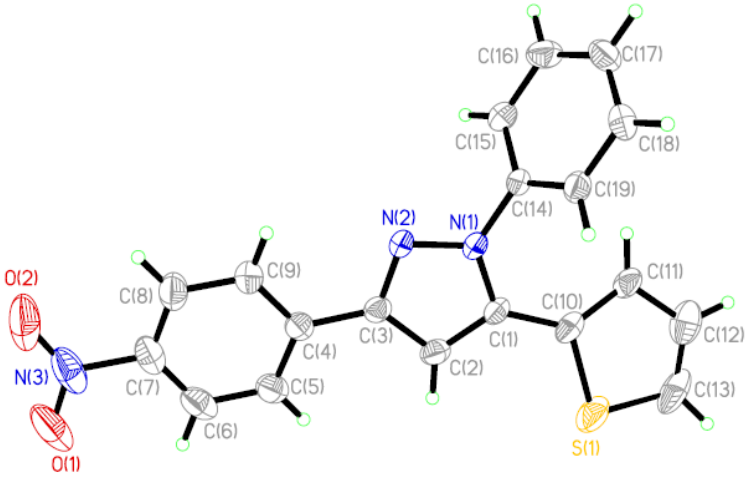
Figure 1. Molecular structure with the atomic numbering scheme for the title compound.